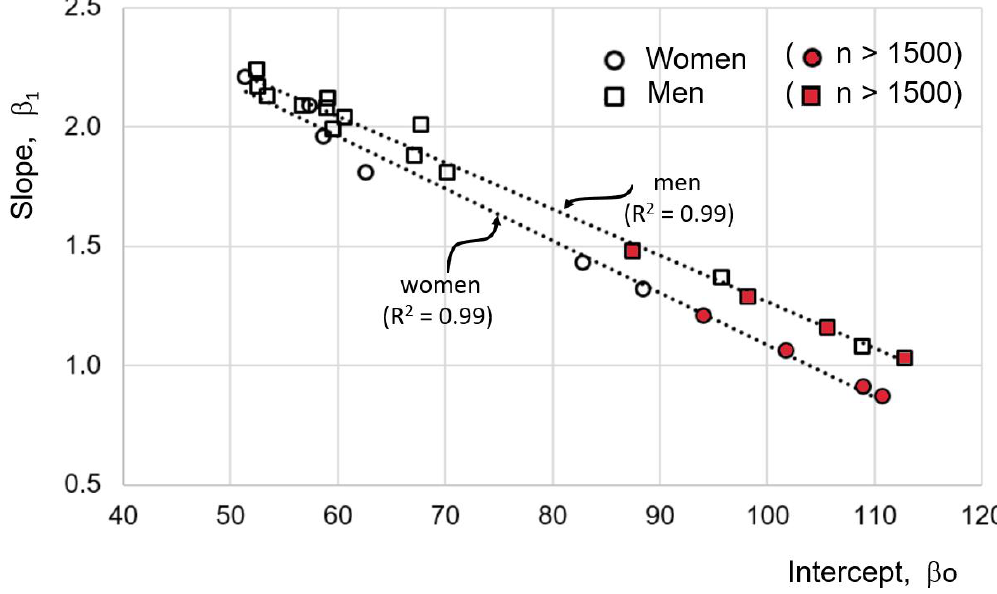
Figure 3. The linear relationship between the β o and β 1 parameters of the lines in Figure 2. Gender (female/male) is an essential variable since the allometric relationship be- tween height and KH is more similar between people of the same gender and a different ethnic group than between people of different gender and the same ethnic group. The mean coefficients of variation (SD divided by the mean) for height are 4.8% and 4.2% for women and men, respectively (Table 5). That is, there is little variability in the participants ’ maximum height in the studies from which the equations were derived. This